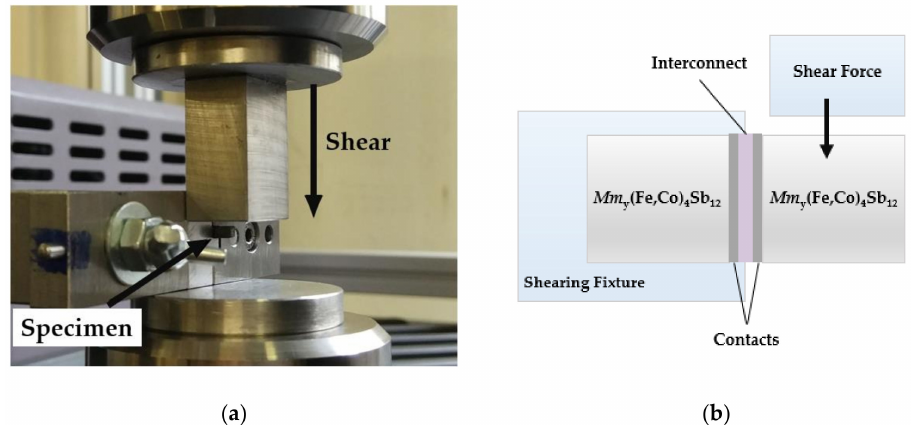
Figure 2. Configuration used for mechanical strength evaluation showing: ( a ) Photograph of sample clamped in the shear test fixture and ( b ) schematic illustration of the specimen and shear test configuration adapted from ASTM D905 standard [24]; the thermoelectric leg length is 3 mm, the copper Ni(P) interconnect is 0.3 mm thick and the contact thickness are ~30 µ m. The shearing blade makes contact with the thermoelectric material ≤ 0.3mm from the